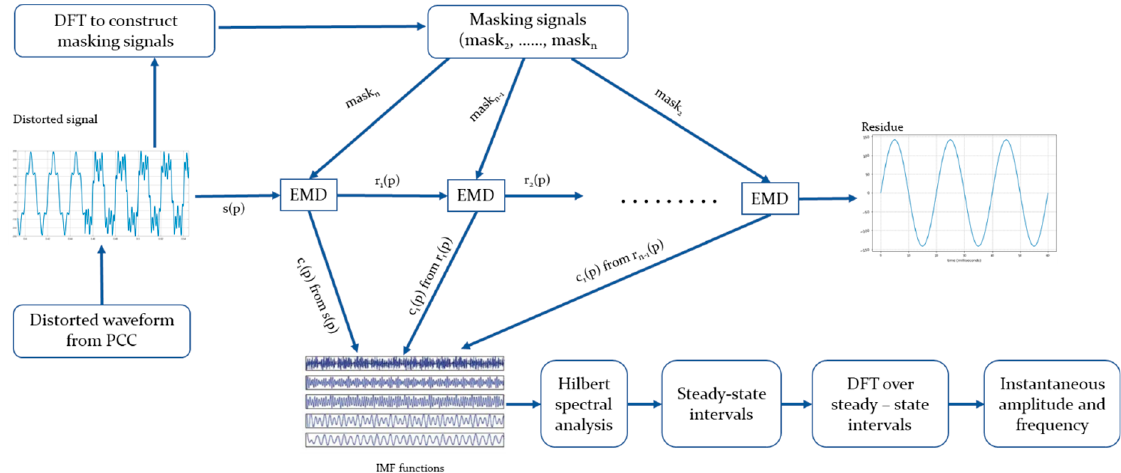
Figure 1. Framework for decomposing distorted signal into high-frequency components using Hilbert–Huang method (adapted from [21]) .